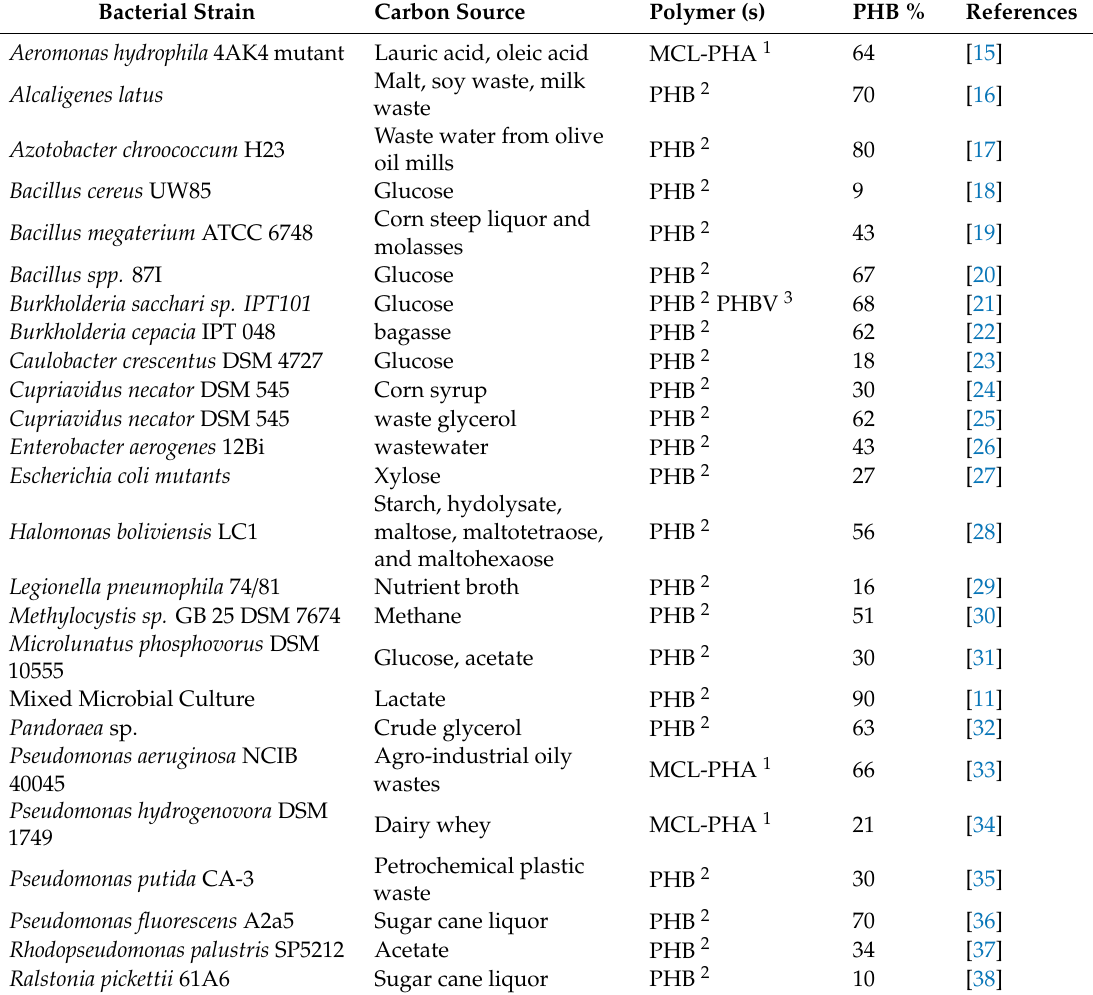
Table 3. Overview of bacterial strains used for the production of